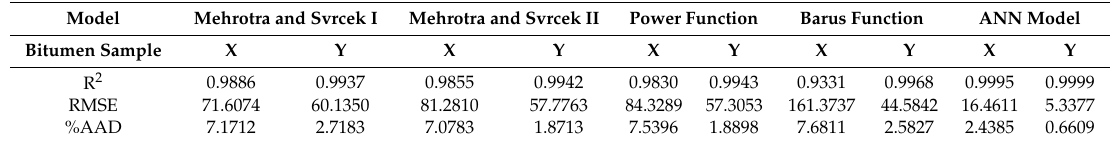
Table 3. Comparison of statistical parameters for the correlations.